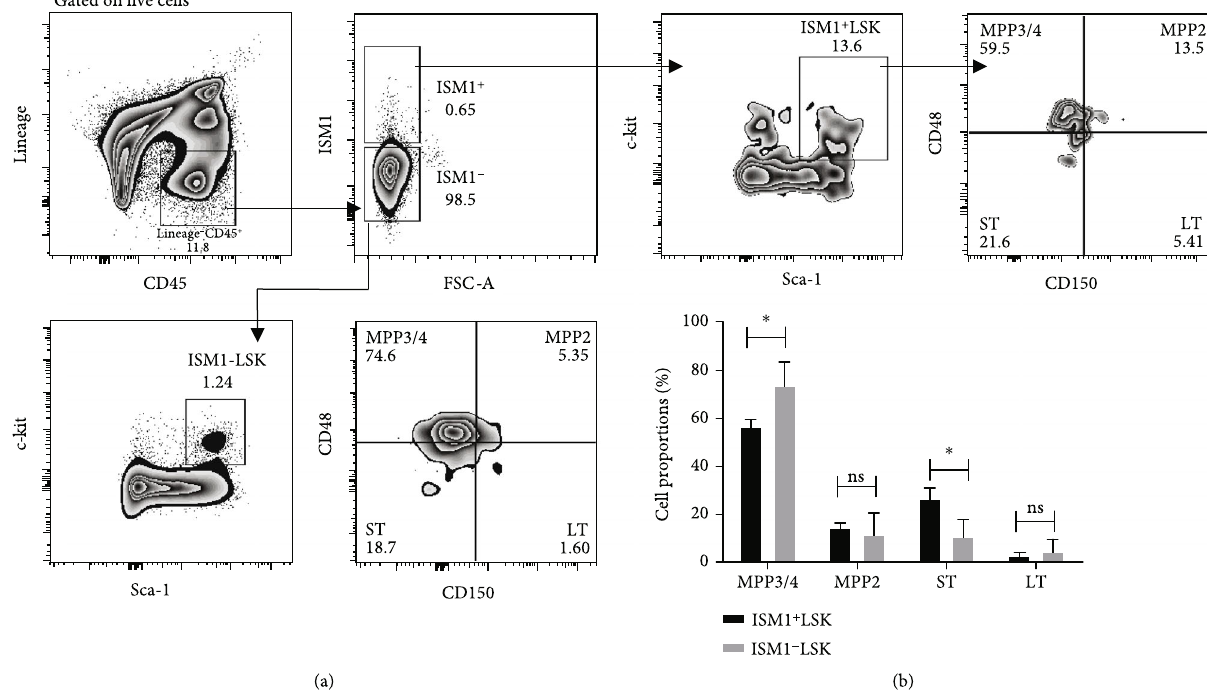
Figure 5: Characterization of ISM1 + LSK cells. (a) Gating strategy to visualize ISM1 + LSK (LIN - CD45 + ISM1 + c-kit + Sca-1 + ) and ISM1 - LSK (LIN - CD45 + ISM1 - c-kit + Sca-1 + ) cell subsets. LIN - CD45 + ISM1 + cells were analyzed for the presence of Sca-1 and c-kit and then analyzed for CD150 and CD48 expression. (b) Percentages of di ff erent HSCs and progenitors are depicted, n = 3 . Data are mean plus SEM n = 3 independent experiments. Statistical analysis was performed one-way ANOVA test, ns: nonsigni fi cant; ∗∗ p < 0 : 01 , ∗∗∗ p < 0 : 001